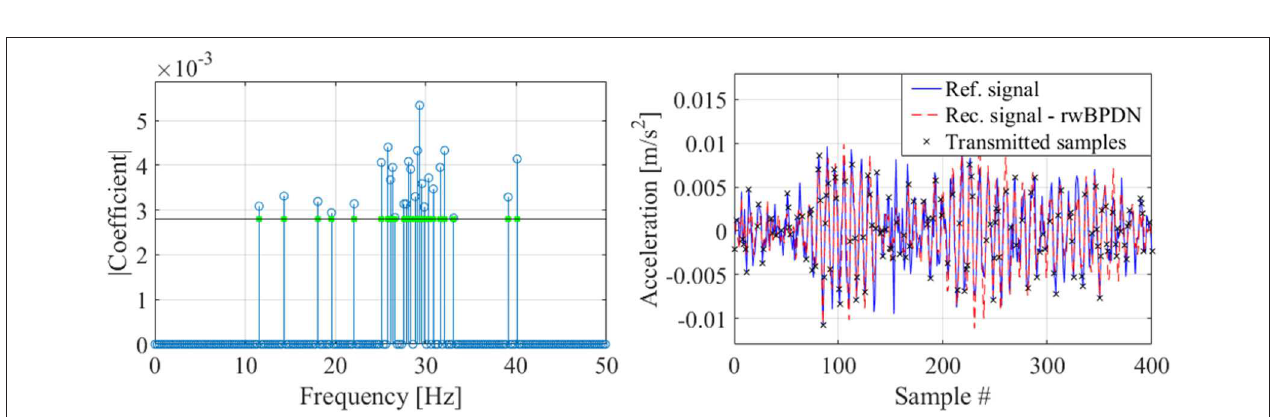
36%. Crosses indicate transmitted samples =